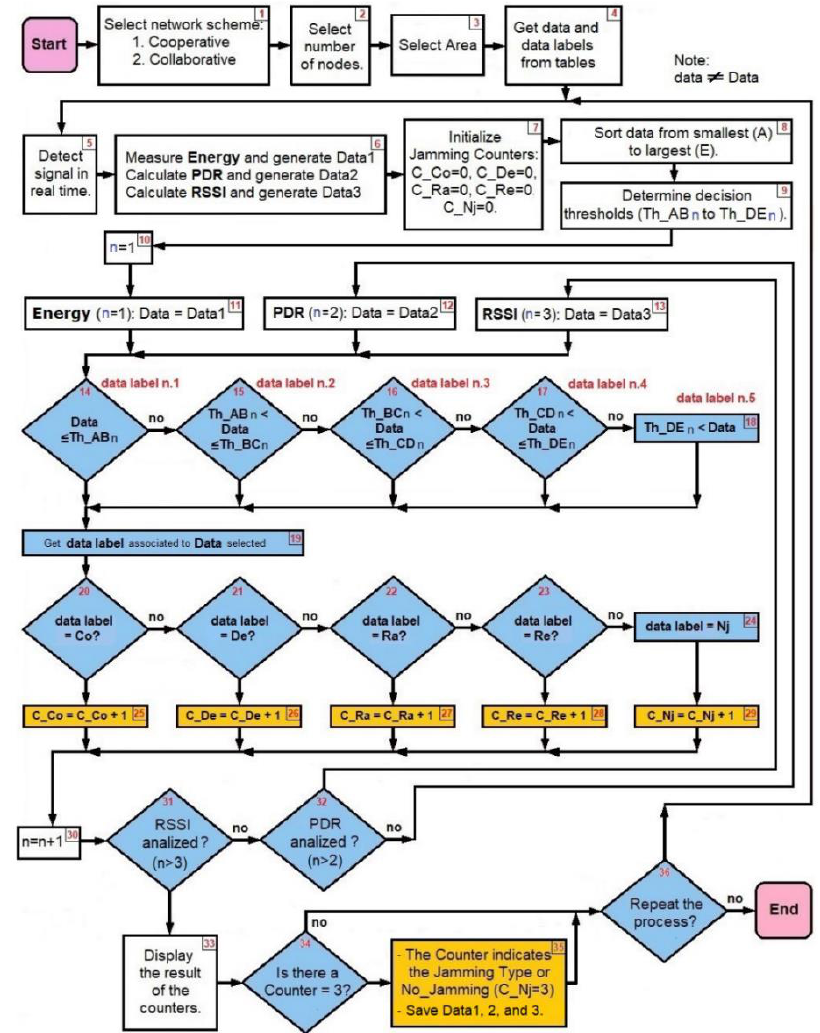
Figure 16. Jamming Detection Algorithm. Image obtained from [107].